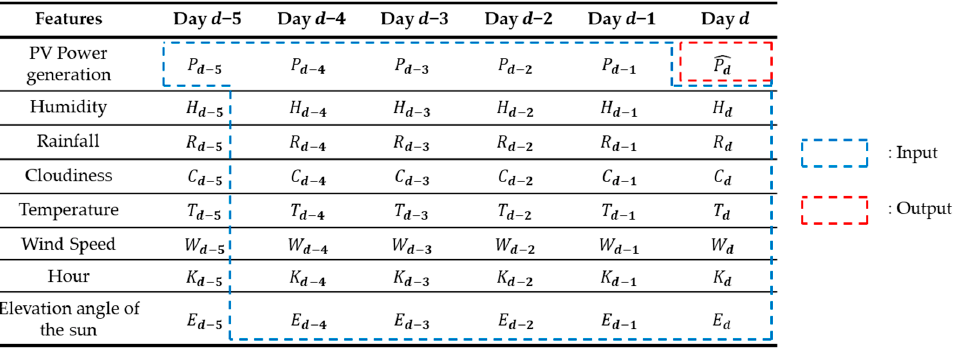
Figure 3. Inputs and outputs at the training phase.